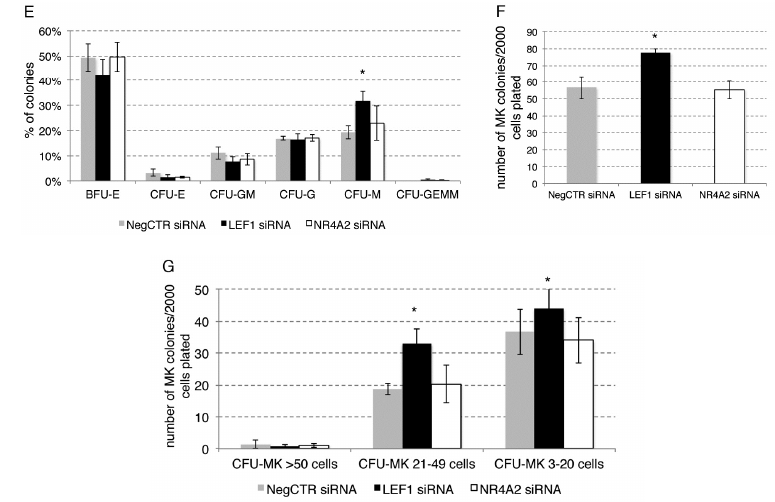
Figure 5. Effects of LEF1 and NR4A2 silencing on CD34+ hematopoietic progenitor cells proliferation and clonogenic activity. ( A ) Detection of LEF1 and NR4A2 expression levels by RT-qPCR in NegCTR siRNA, LEF1 siRNA and NR4A2 siRNA-transfected CD34+ cells at 24 h post-nucleofection; ( B ) Western Blotting analysis of Lef1 ( i ) and Nr4a2 ( ii ) protein levels in LEF1 siRNA ( i ) or NR4A2 siRNA ( ii ) compared to NegCTR siRNA-transfected CD34+ cells at 24 h after the last of two nucleofection cycles. Actin protein levels are reported as loading control; ( C ) Statistical analysis results (mean ± SEM; n = 3) for the percentage of cells in the different cell cycle phases performed by propidium iodide staining 24 h post-nucleofection; ( D , E ) Methylcellulose clonogenic assay results (mean ± SEM; n = 3). The colony scoring results are reported as total number of colonies grown from 200 cells plated ( D ) and percentages of each colony type ( E ); Colonies were scored according to the manufacturer’s guidelines; ( F , G ) Megakaryocyte clonogenic assay results (mean ± SEM; n = 3) in terms of megakaryocyte colony number ( F ) and size ( G ). Values are reported as number of megakaryocyte colonies for 2000 plated cells. Error bars in the graphs represent SEM. * p ≤ 0.05, ** p ≤ 0.01 and *** p ≤ 0.001 vs. NegCTR siRNA sample. Abbreviations: BFU-E, burst forming unit-erythroid; CFU-E, colony forming unit-erythroid; CFU-GM, colony forming unit-granulocyte/monocyte; CFU-G, colony forming unit-granulocyte; CFU-M, colony forming unit-monocyte; CFU-GEMM, colony forming unit-granulocyte/erythroid/monocyte/megakaryocyte; MK, megakaryocyte; CFU-MK, colony forming unit-megakaryocyte; n = number of